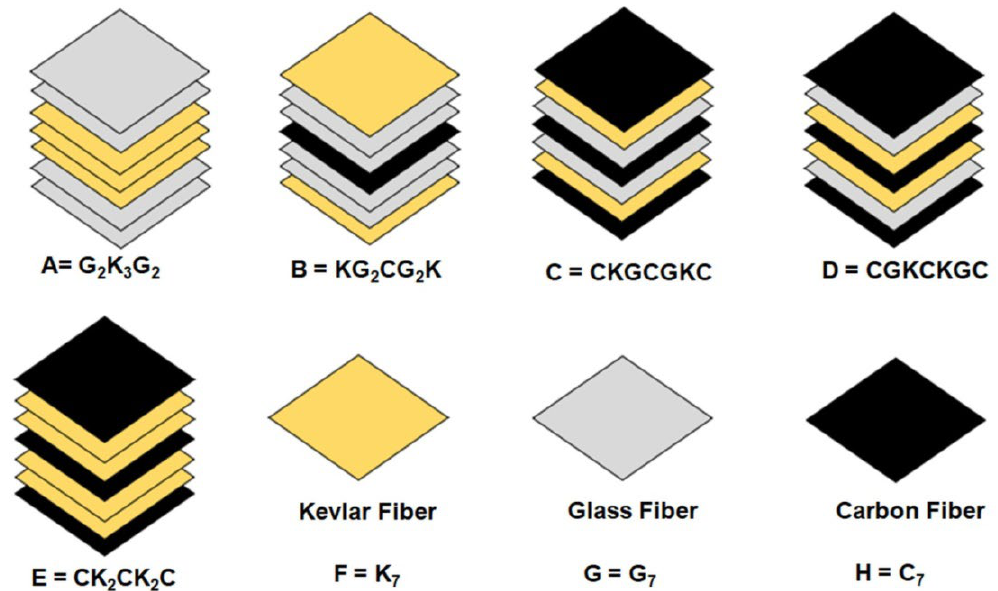
Figure 1. Schematic diagram of stacking sequence of plain and hybrid